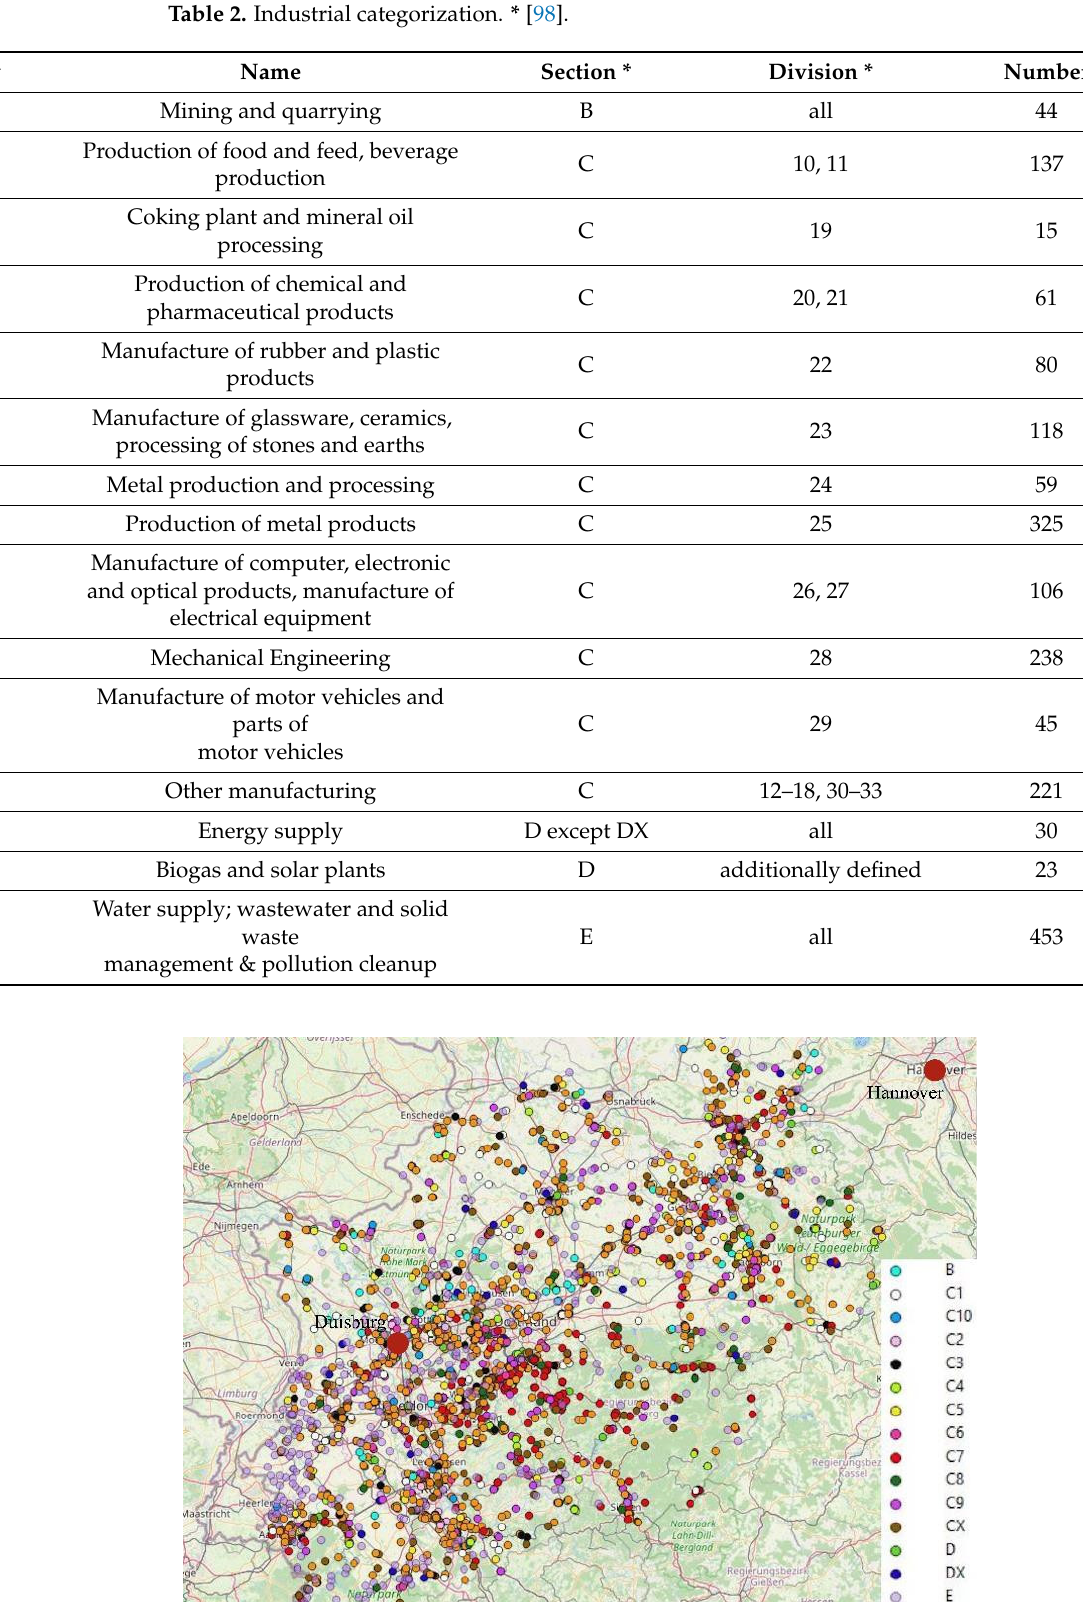
Table 2. Industrial categorization. * [98].